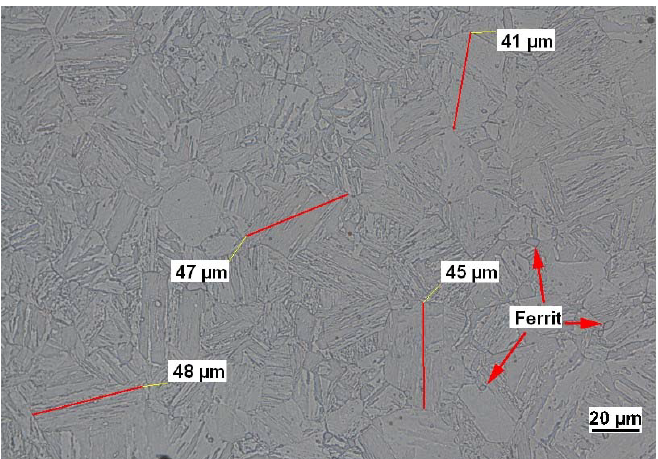
Figure 1. Representative metallographic image of material 1.4418. The image was taken from a sample prepared with V2A-etchant, which consists out of 100 mL distilled water +100 mL concentrated hydrochloric acid +10 mL concentrated nitric acid + 0.3 mL spare